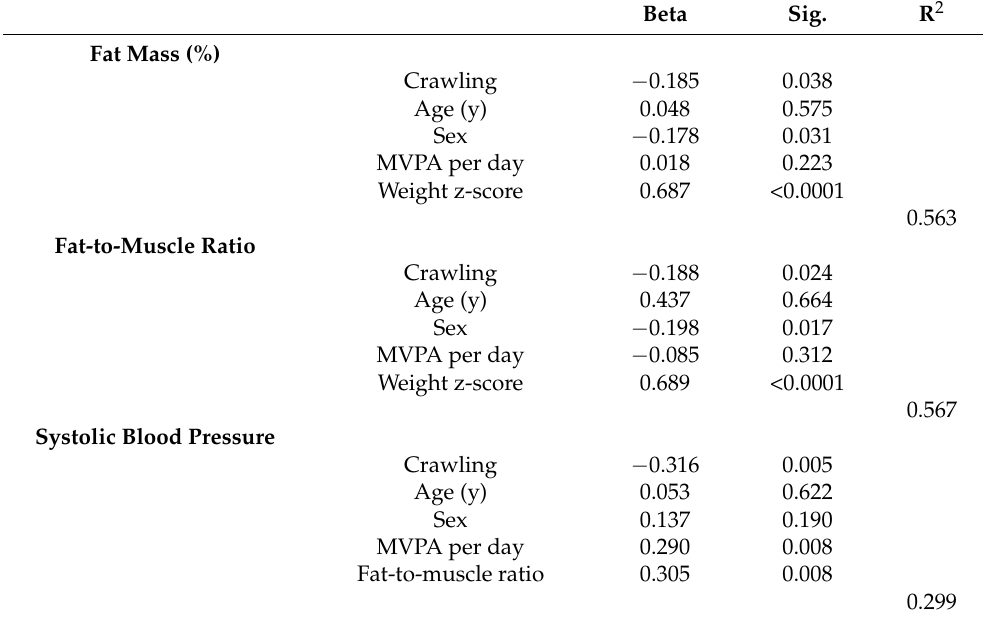
Table 2. Multivariate linear models in all children ( n = 77; crawlers ( n = 42) and non-crawlers ( n = 35)). Upper table: fat mass (%) as a dependent variable, middle table: fat-to-muscle ratio as dependent variable and lower table: systolic blood pressure as dependent variable. Beta Sig. R